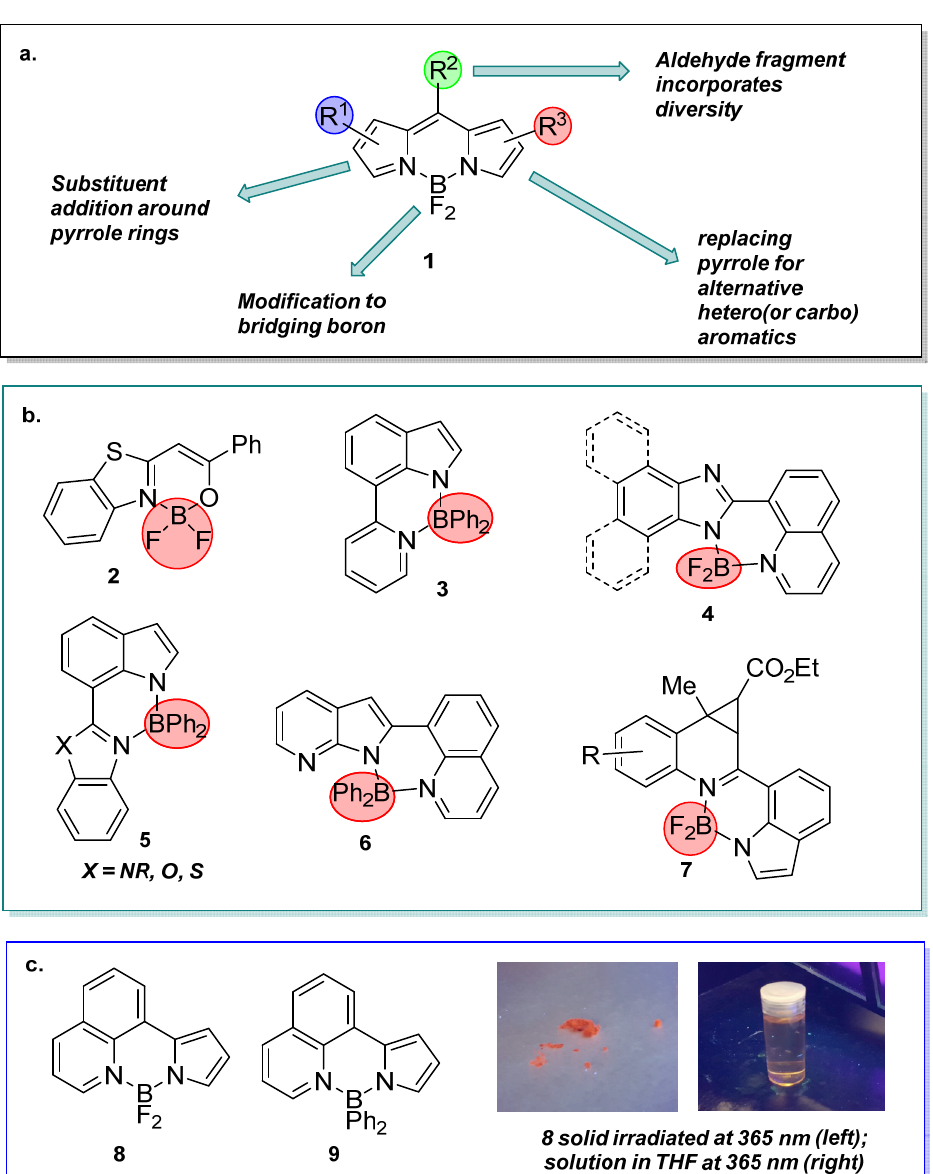
Figure 1. ( a ) Selected sites of modification to a classical BODIPY core 1 ; ( b ) selected examples of BODIPY analogues bearing heteroaromatic moieties 2–7 ; ( c ) structures of BF 2 and BPh 2 pyrrolylquinoline derivatives 8 and 9 included in this study, with images showing appearance under 365 nm light irradiation.